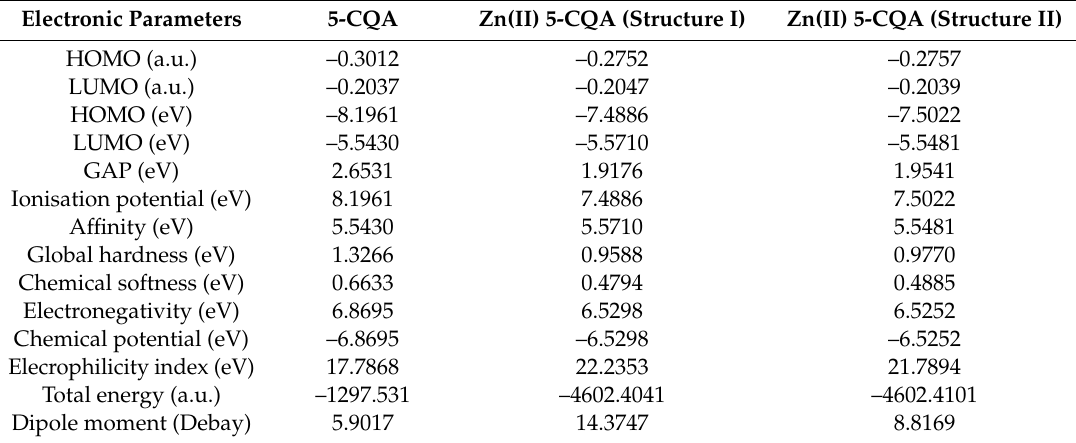
Table 5. Calculated in B3LYP / 6-31G(d) level the electronic parameters for 5-CQA and two structures of Zn(II) 5-CQA presented in Figure 6.